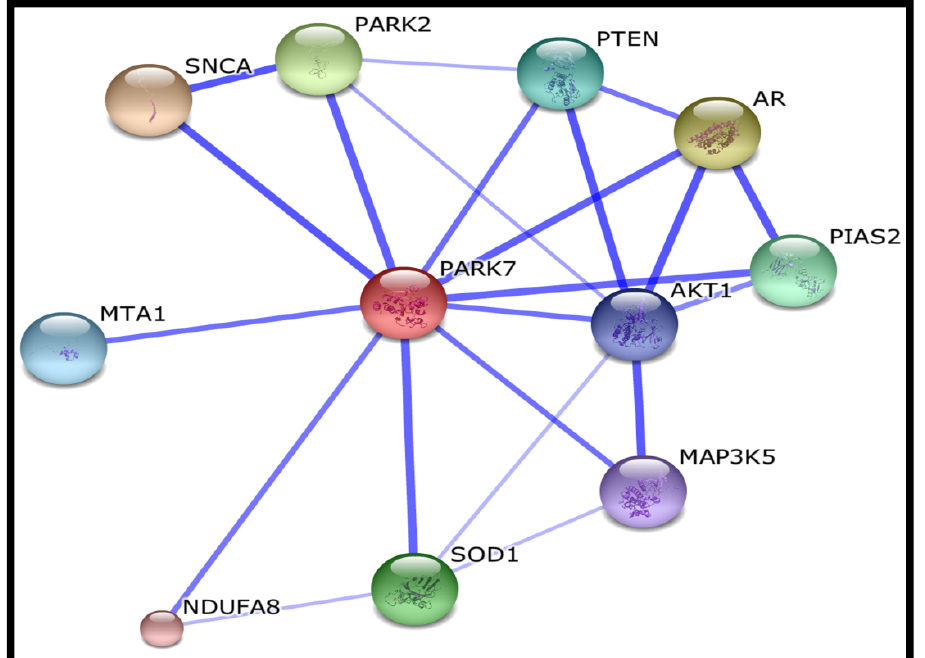
Figure 3. Protein interactions of the redox-sensitive succination target PARK7/DJ-1.